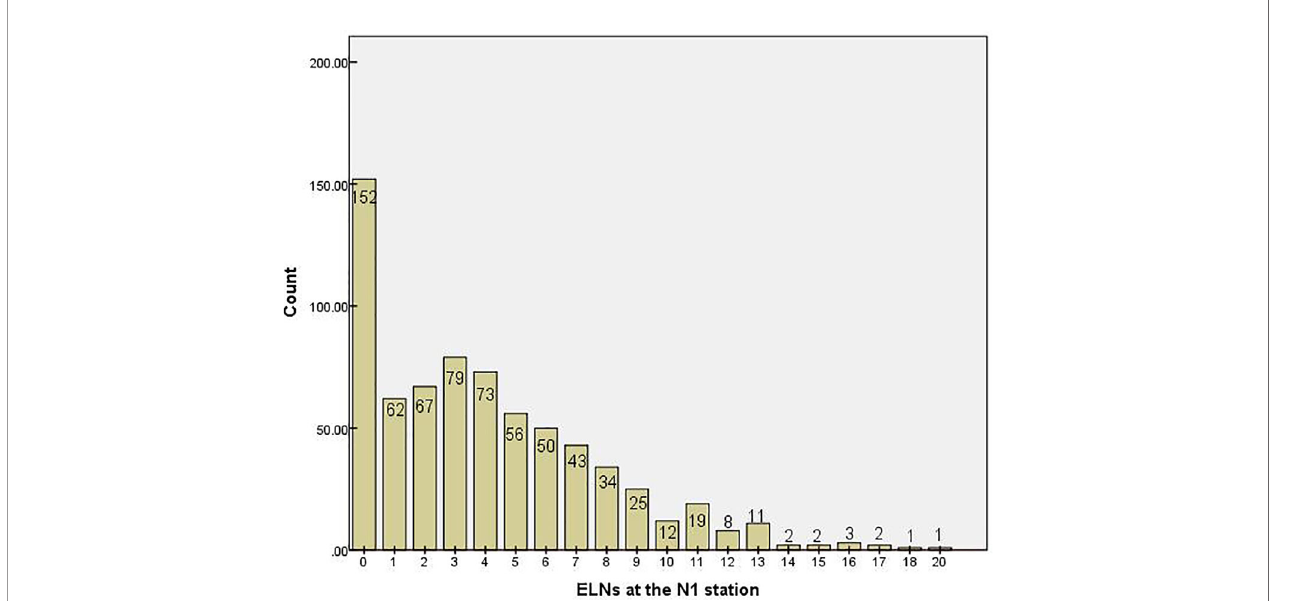
FIGURE 1 | Distribution of the number of examined lymph nodes at the N1 stationin. ELN, examined lymph